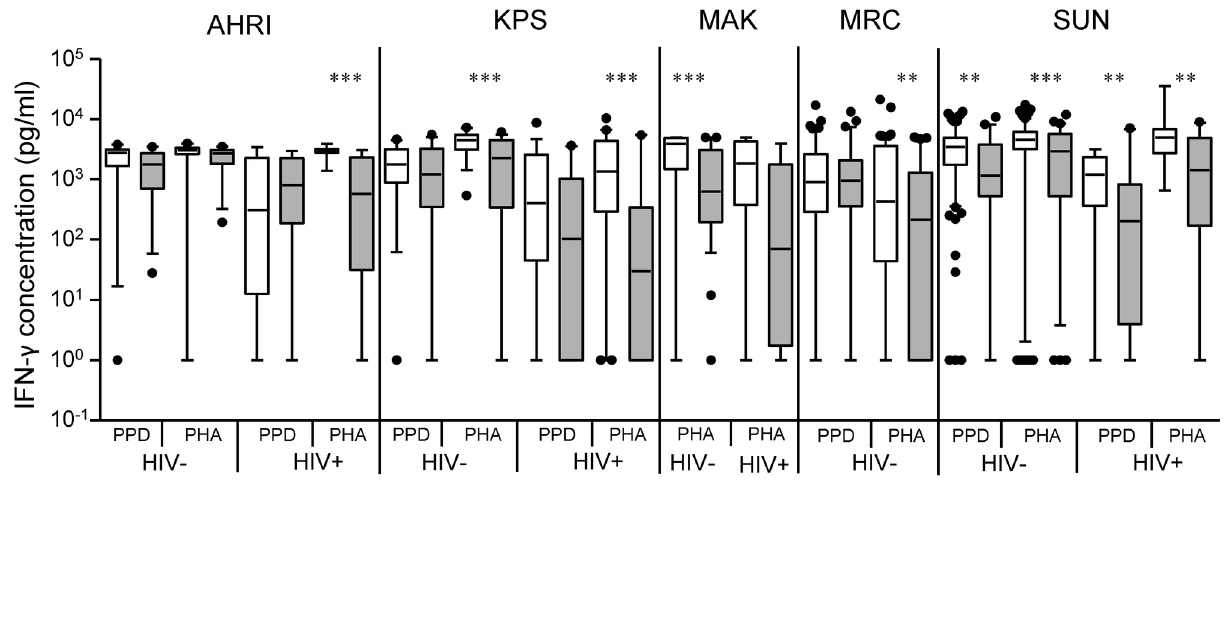
Figure 2. IFN-γ secretion in response to secreted, latent, and reactivation Mtb antigens in active TB and LTBI subjects, from five African sites. IFN-γ ELISA was performed on supernatants collected after 7-day antigen stimulation of diluted blood from TB cases (grey) and TST + (LTBI) controls (white) from five sites in Africa. Line indicates median, whiskers indicate 5–95% range and dots indicate outliers. Data were analysed by Mann-Whitney U-test within sites for HIV – and/or HIV + subjects. Significant differences are indicated: *=p<0.05; **=p<0.01; ***=P<0.001. doi: